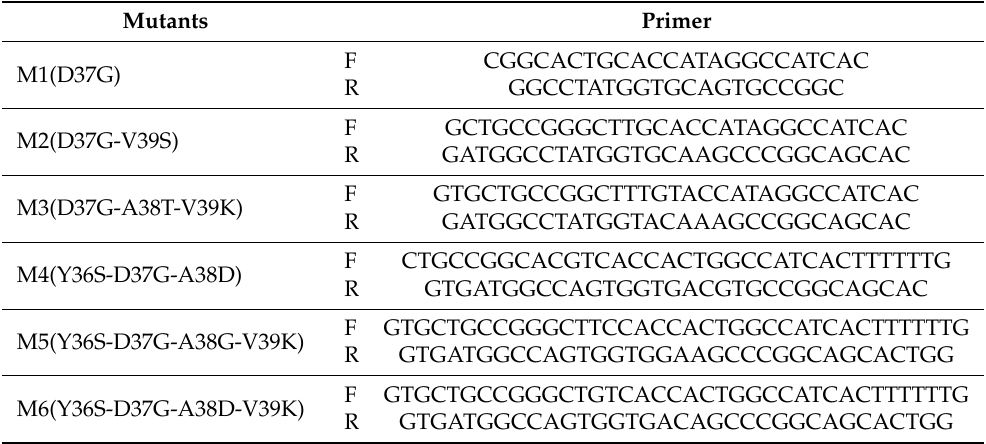
Table 4. Primers used for